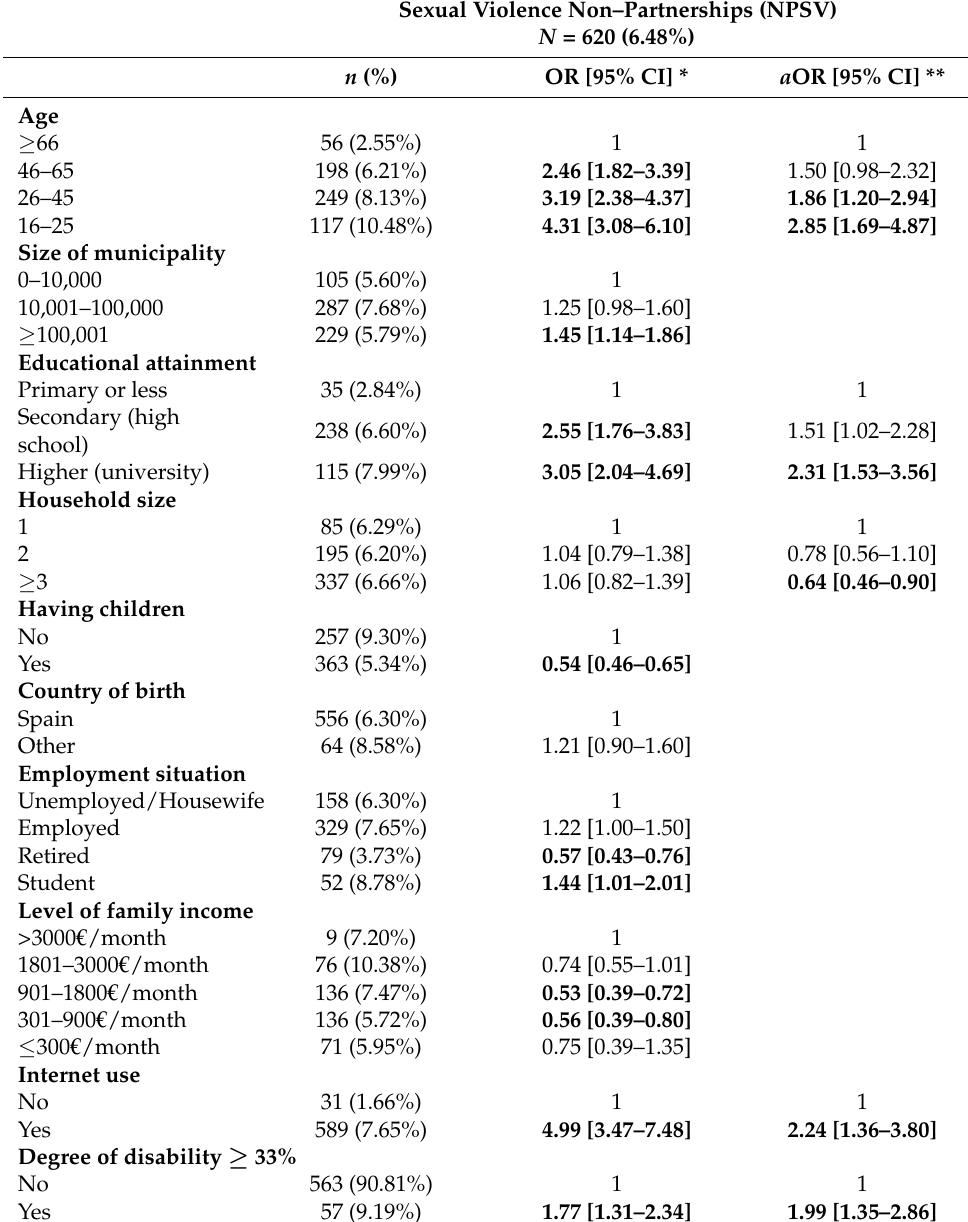
Table 2. Association between sociodemographic characteristics and